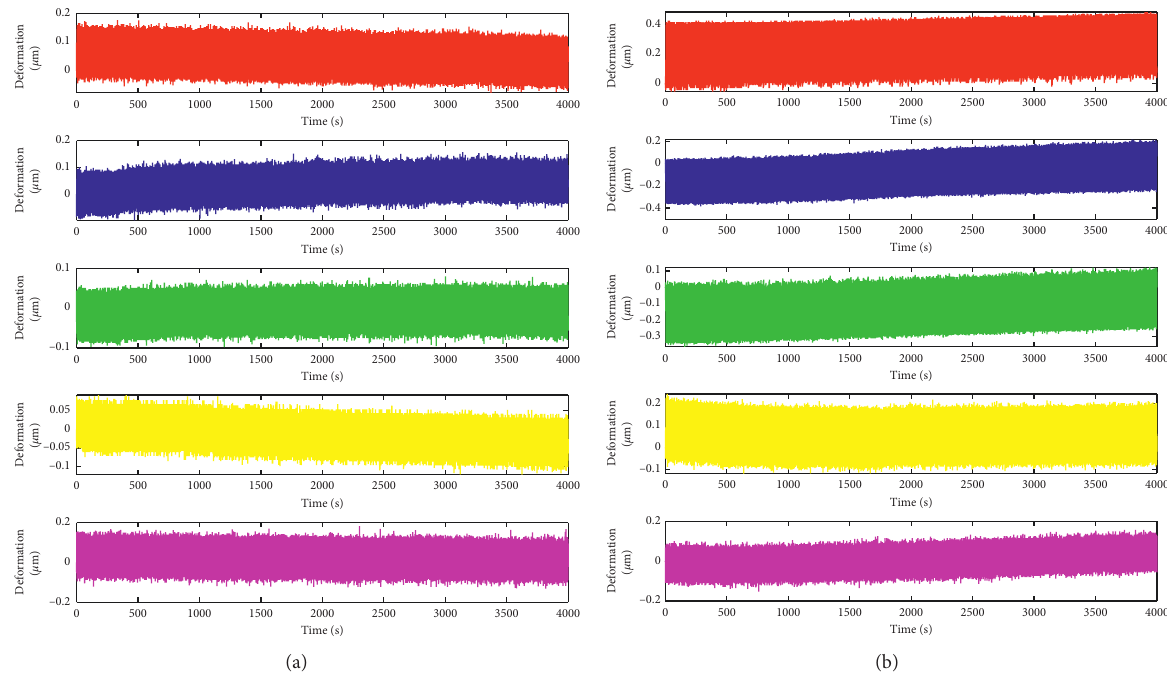
Figure 10: 4000s cycle loading test with the block on the right side. (a) On the top position. (b) On the low